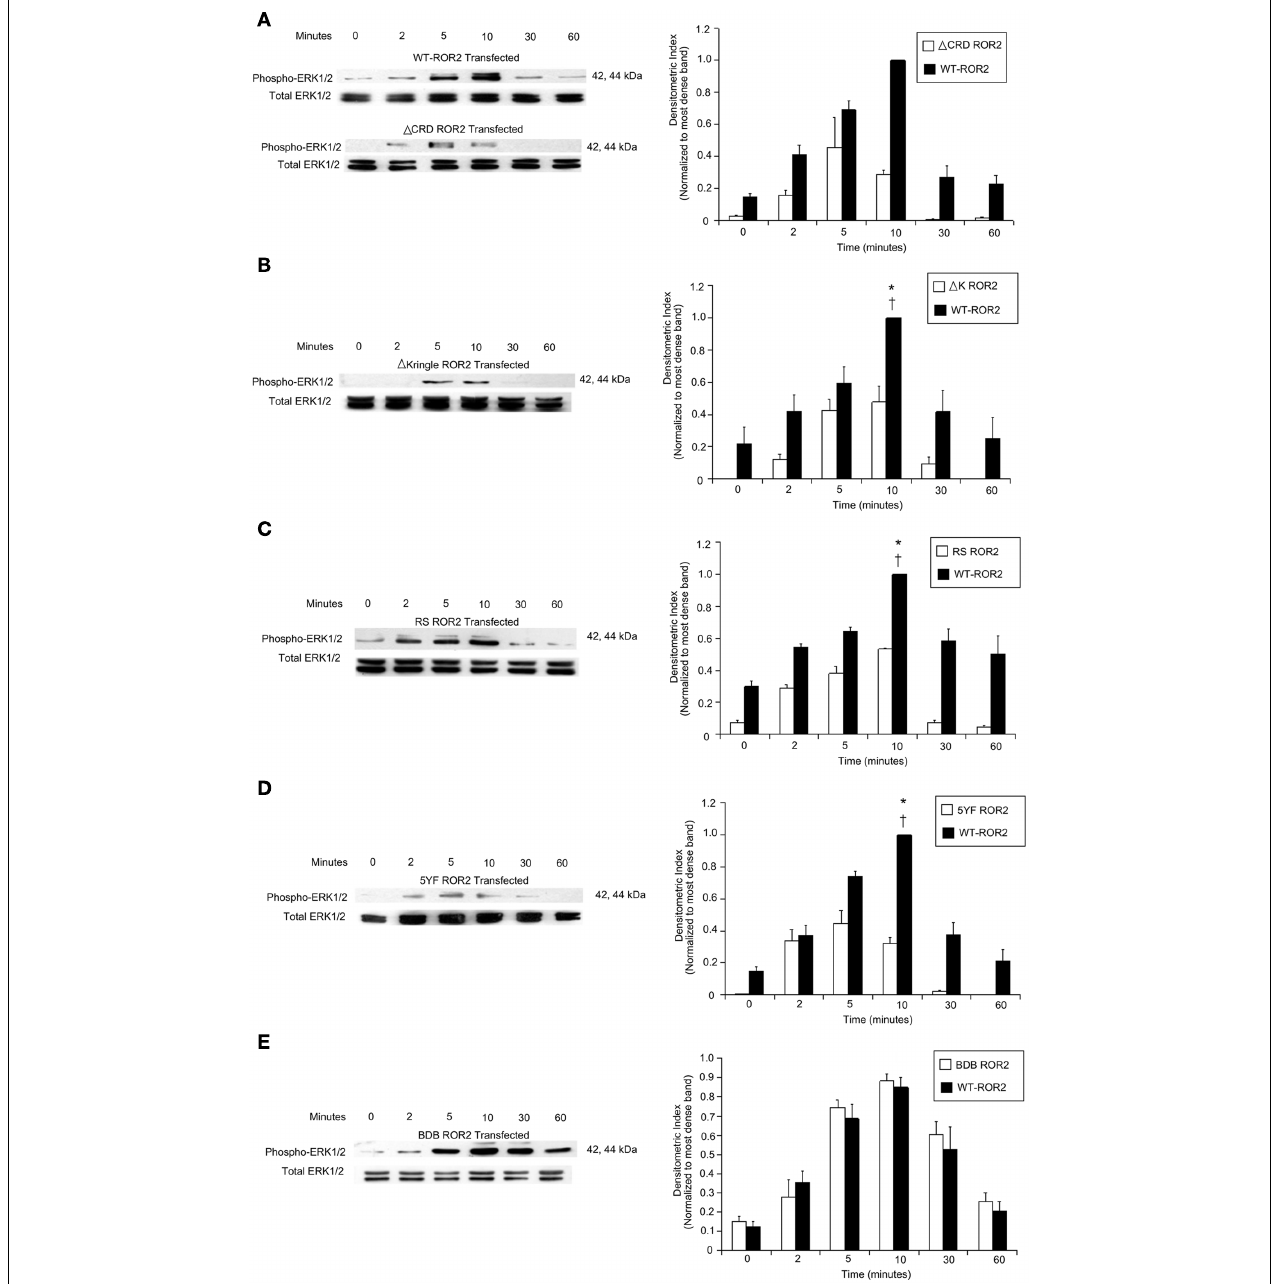
an internal loading control.The blots discussed are representative of three separate experiments with similar results. (A–E) Right panels: densitometry confirmed that maximal ERK1/2 phosphorylation in Wnt5a-challengedWT Ror2 control cells consistently occurred at 10min. Additionally, maximal ERK1/2 phosphorylation was significantly more intense compared to baseline and compared to ERK1/2 phosphorylation in similarly treated cells expressing a truncated or mutated Ror2. (E) Right panel: the pattern and degree of ERK1/2 phosphorylation was conserved in BDB Ror2-transfected cells challenged withWnt5a. Results are expressed as means ± SD of three independently performed experiments. * P < 0.05 compared to 10min ofWnt5a CM incubation in truncated or mutant Ror2-transfected cells. †P < 0.05 compared to 0min ofWnt5a incubation inWT Ror2-transfected